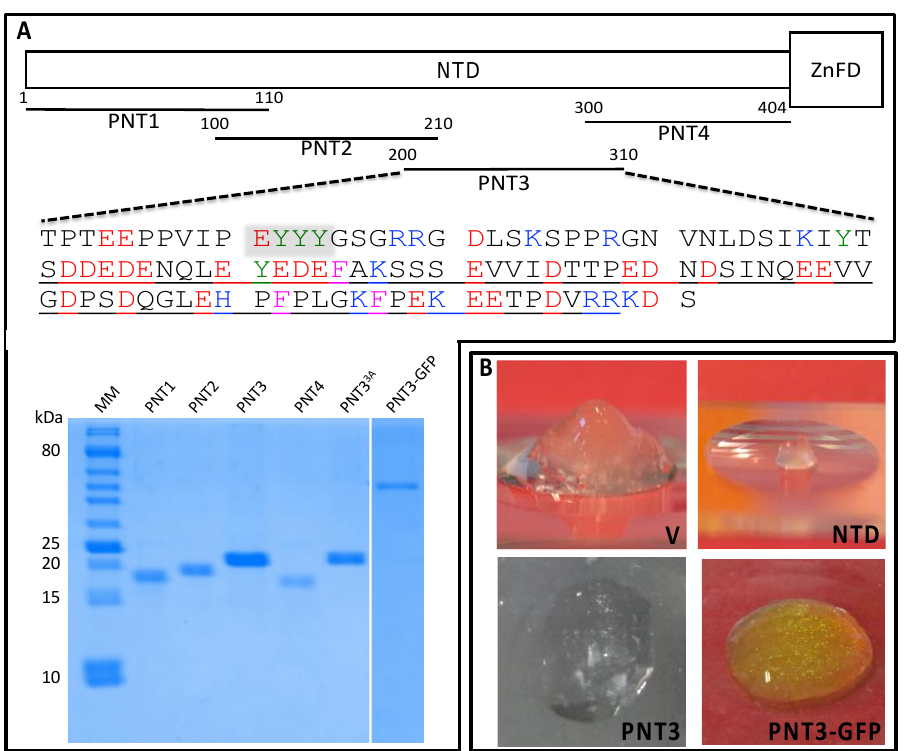
Figure 2. ( A ) Schematic organization of the HeV V protein (top) and SDS-PAGE analysis of purified proteins (bottom). The intrinsically disordered N-terminal domain (NTD) and the zinc finger domain (ZnFD) are represented as a narrow and large box, respectively. The various overlapping fragments within the NTD herein generated are shown. The amino acid sequence of PNT3 is shown, with the most amyloidogenic region, as predicted by FoldAmyloid [63], Aggrescan [64], and ArchCandy [65] (see Section 3.7.), framed in yellow. The low complexity region, as identified by SEG [66], is underlined. Tyr residues are shown in green, acidic residues in red, basic residues in blue, and phenylalanines in pink. SDS-PAGE analysis of the purified PNT1-4 fragments of PNT3 3A and of PNT3-GFP. Abbreviation: MM, molecular mass markers. ( B ) Hydrogels formed upon freezing and thawing of either purified V, NTD, PNT3 (all at 200 μM ), or of purified PNT3-GFP (at 1 mM).